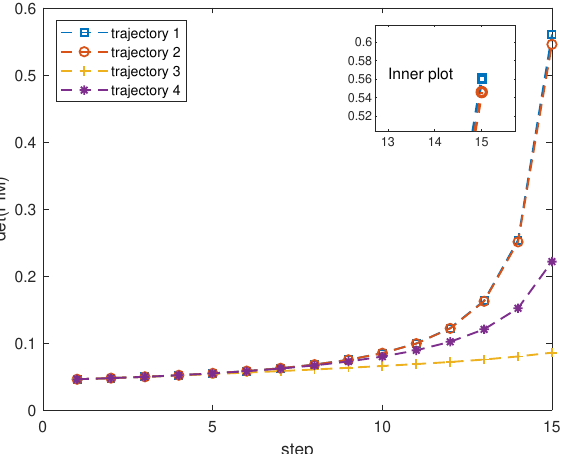
Figure 9. Comparison of the mean of det ( FIM k ) for four trajectories over 100 Monte Carlo runs. The trajectories simulation results are shown in Figure 10. In the process of trajectory planning, the predicted sensor position keeps getting closer to the target. When the sensor motion area is separated from the target safety area, S k + 1 sits on the movement boundary sphere centering at S k .